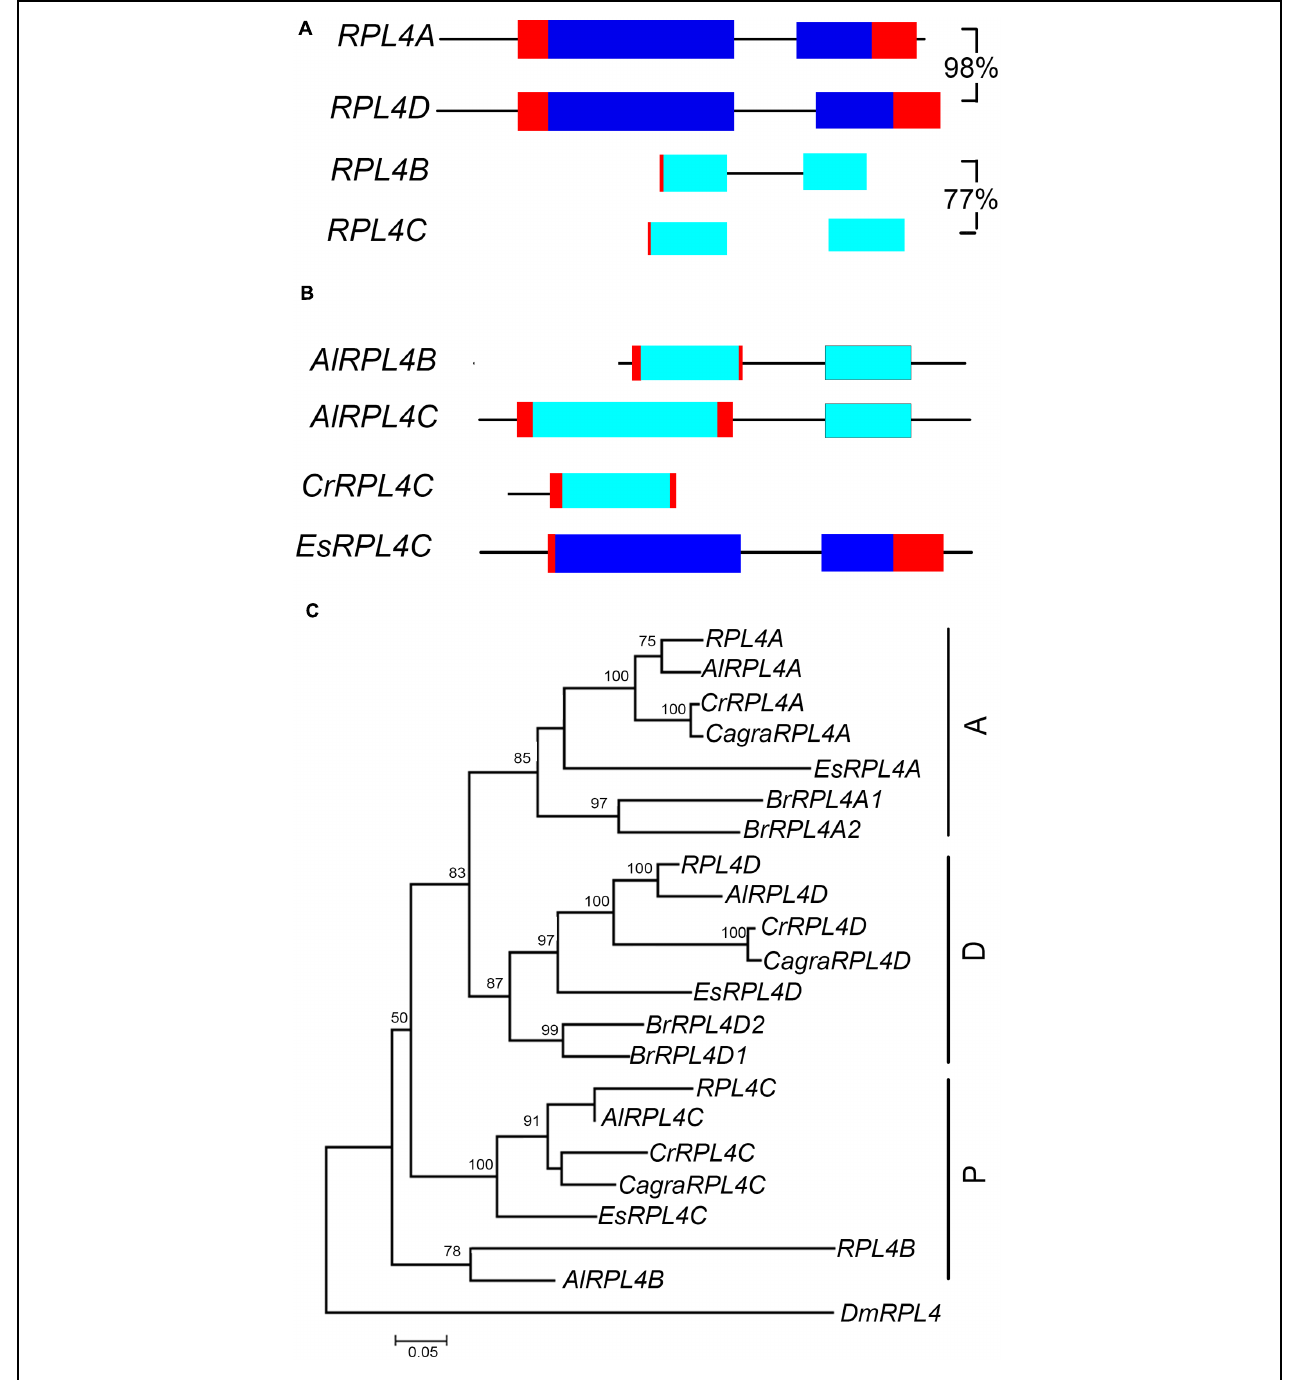
FIGURE 5 | RPL4 genes in Brassicaceae. Diagrammatic representation of A. thaliana A group (A) and P group genes (B) showing UTR’s (red), exons (blue), non-coding upstream, and intron sequences (black line), and putative non-functional coding sequences (light blue). Percentage nucleotide sequence identity of exons is shown for A. thaliana genes and pseudogene pair. Phylogenetic tree of RPL4 genes in Brassicaceae (C) includes genes of species listed in Figure 3 . The C. grandiflora RPL4C gene sequence used in phylogenetic analysis is likely incomplete.